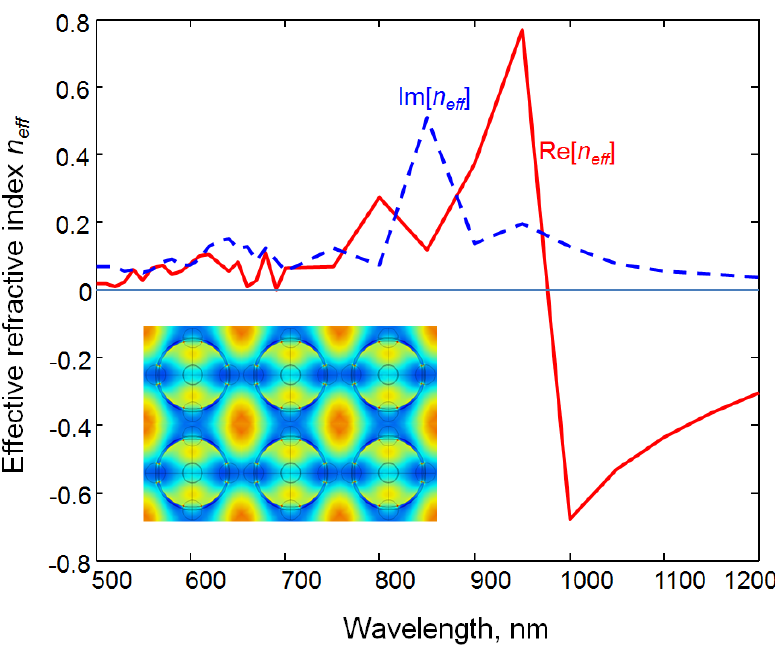
Figure 14. Spectral dependence of extracted effective refractive index of a square planar array of gold hollow spheres with a 600 nm diameter, their wall thickness 20 nm, perforated by holes with a 160 nm diameter and a distance between two neighboring spheres 200 nm. Solid red line: real part of the effective refractive index of the array of brochosome-like perforated microspheres. Dashed blue line: imaginary part of the effective refractive index of the array of brochosome-like perforated microspheres. Inset: 6 unit cells of the square array of brochosome-like perforated microspheres showing electric field distribution at 520 nm.